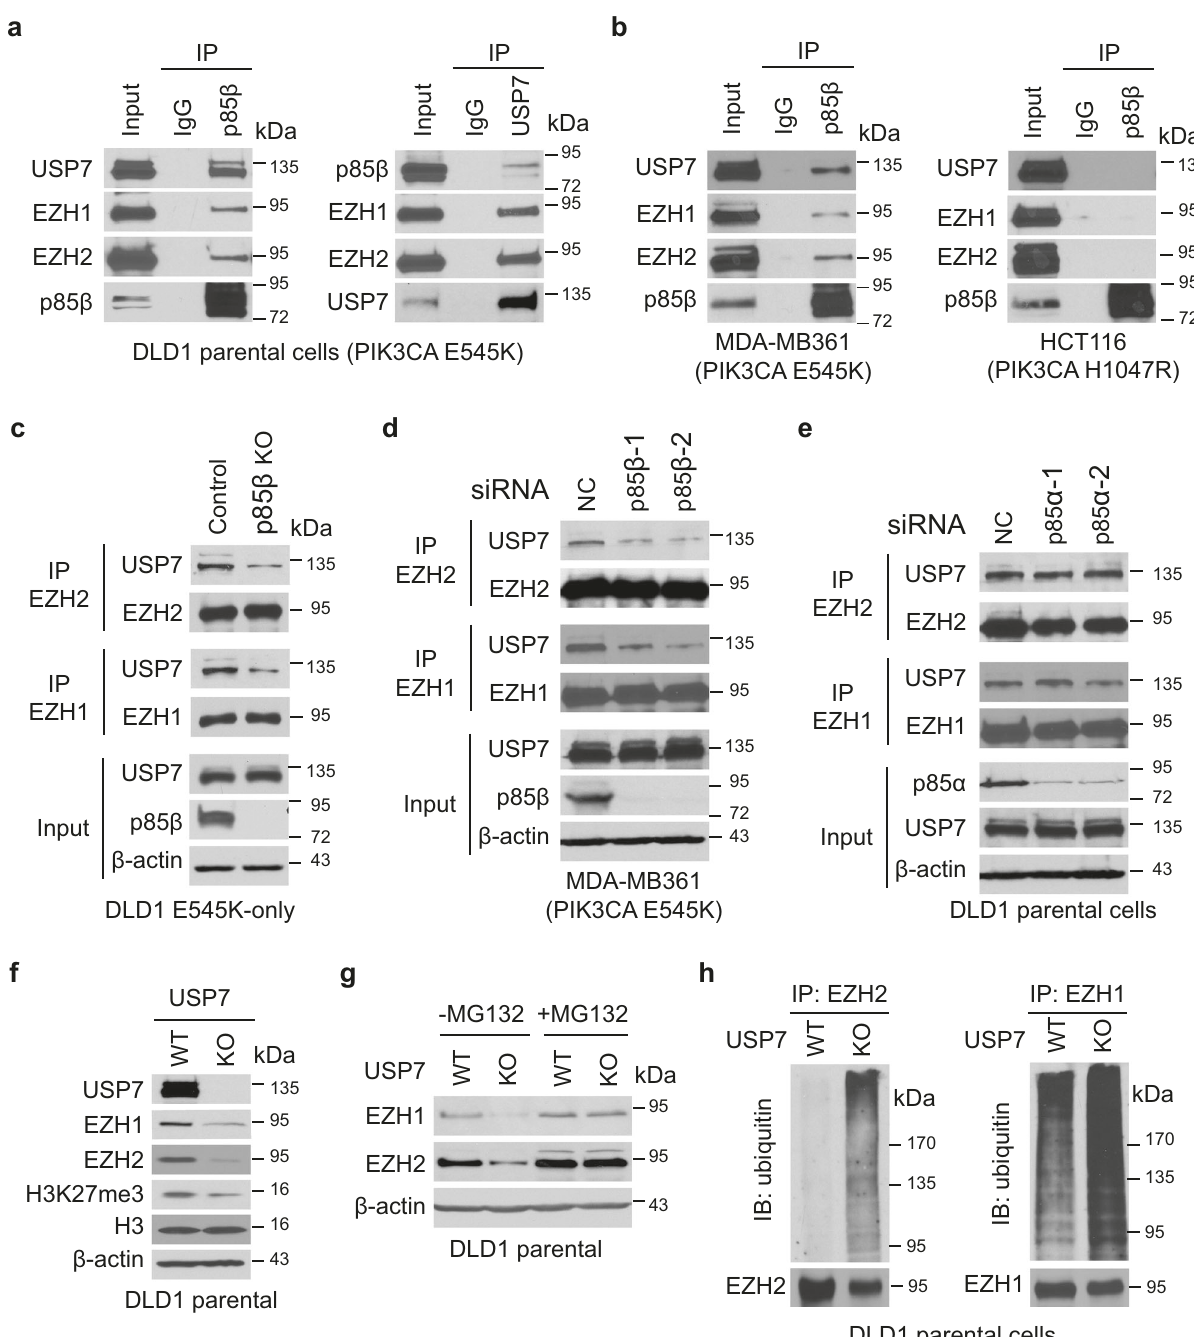
Fig. 6 Nuclear p85 β recruits the deubiquitinase USP7 to stabilize EZH1/2, increasing H3K27 tri-methylation. a Nuclear p85 β interacts with USP7, EZH1, and EZH2. DLD1 PIK3CA E545K cells were lysed and immunoprecipitated (IP) with either an anti-p85 β or an anti-USP7 antibody, then blotted with indicated antibodies. b Nuclear p85 β interacts with USP7, EZH1, and EZH2 in PIK3CA E545K mutant cells, but not in PIK3CA H1047R mutant cells. c The interaction between USP7 and EZH1 or EZH2 is reduced in p85 β knockout cells. The indicated cell lines were lysed, IPed with either EZH1 or EZH2, then blotted with indicated antibodies. d The interaction between USP7 and EZH1 or EZH2 is reduced in p85 β knockout PIK3CA E545K mutant MB361 cells. MB361 cells were transfected with scrambled siRNA (NC) or two independent siRNA against p85 β . Cell lysates were IPed with either EZH1 or EZH2, then blotted with indicated antibodies. e Knockdown of p85 α does not impact the interaction between USP7 and EZH1 or EZH2. DLD1 PIK3CA E545K cells were transfected with scrambled siRNA (NC) or two independent siRNA against p85 α . Cell lysates were IPed with either EZH1 or EZH2, then blotted with indicated antibodies. f – h Deubiquitinase USP7 protects EZH1 and EZH2 from ubiquitin-mediated degradation. Lysates of DLD1 parental cells and USP7 knockout cells were blotted with indicated antibodies ( f ). DLD1 parental cells and USP7 knockout cells were treated with either vehicle or MG132 for 6 h and then blotted with indicated antibodies ( g ). After being treated with MG132 for 6 h, DLD1 parental cells and USP7 knockout cells were lysed, IPed with an antibody against either EZH1 or EZH2, then blotted with indicated antibodies ( h ). Similar results were reproduced three